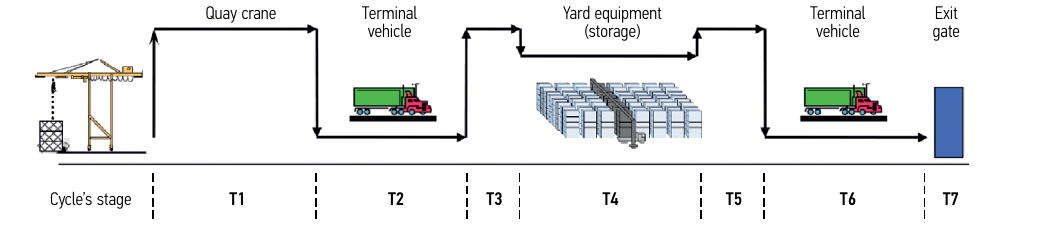
Fig. 2. The stages of the container handling Table 1. The results of assessing factor weight